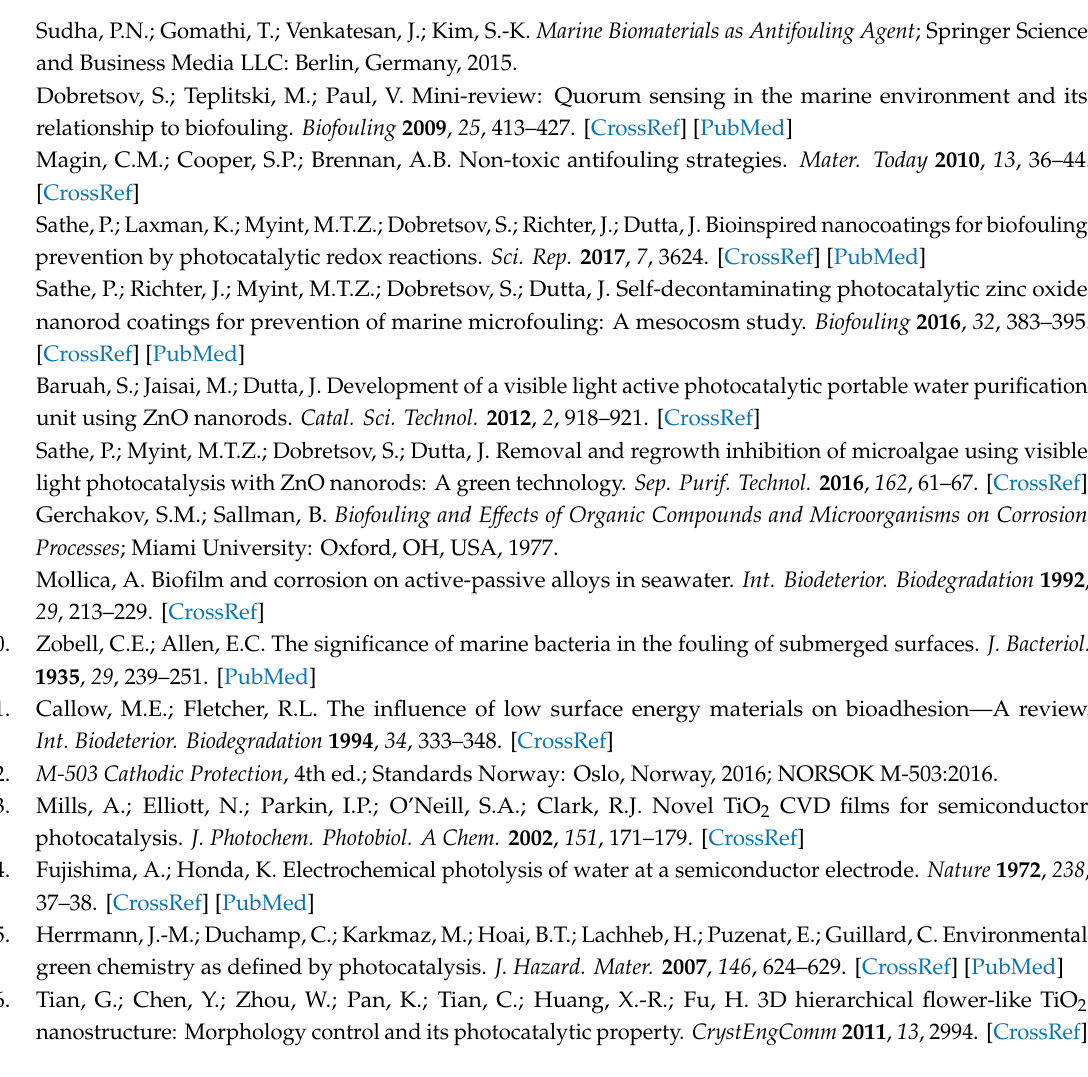
Figure S1: XRD Patterns for TiO 2 / Al-Zr thin films without microflowers deposited at (a) 500 ◦ C, (b) 550 ◦ C and (c) Al-Zr, Figure S2: XRD patterns for TiO 2 / Al-Zr thin films with microflowers deposited at (a) 550 ◦ C, (b) 540 ◦ C and (c) 500 ◦ C on (d) Al-Zr, Figure S3: SEM images of TiO 2 / Al-Zr film without microflowers deposited at 550 ◦ C, Figure S4: Decomposition of Orange G by TiO 2 / Al-Zr thin films with microflowers (left) deposited at (a) 550 ◦ , (b) 540 ◦ C, (c) 500 ◦ C and (d) Al-Zr as underlayer Zr under UV light (371 nm) irradiation time. TiO 2 / Al-Zr thin films without microflowers (right) deposited at (a) 500 ◦ C and (b) 550 ◦ C and (c) Al-Zr underlayer under UV light (371 nm) irradiation